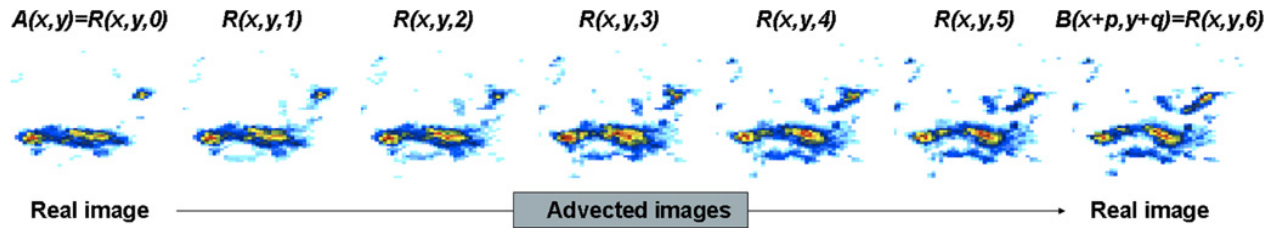
Fig. 7. Real example of radar rainfall disaggregation. In the above example 3 × 3 templates are shown in each image. The original resolution is 6min and the cross-correlation advection results in a 1min